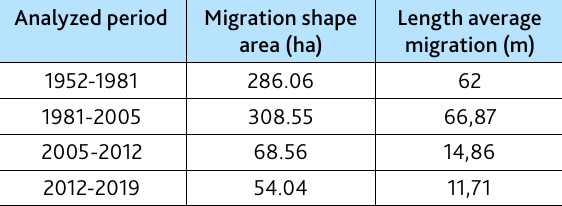
Table 1. Channel migration results